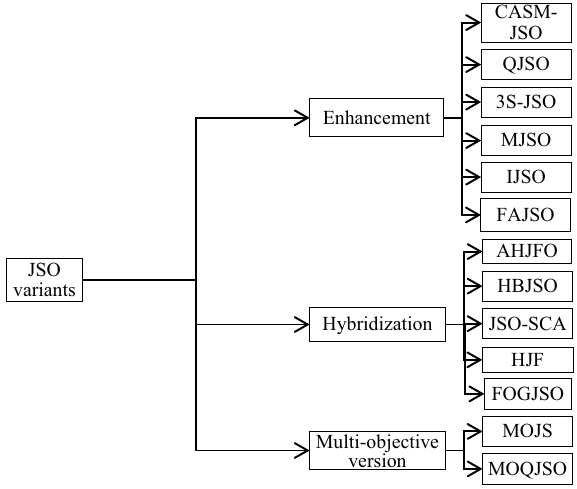
Figure 4. JSO enhancement and its